Question: Briefly state, in one sentence, what is plotted here.
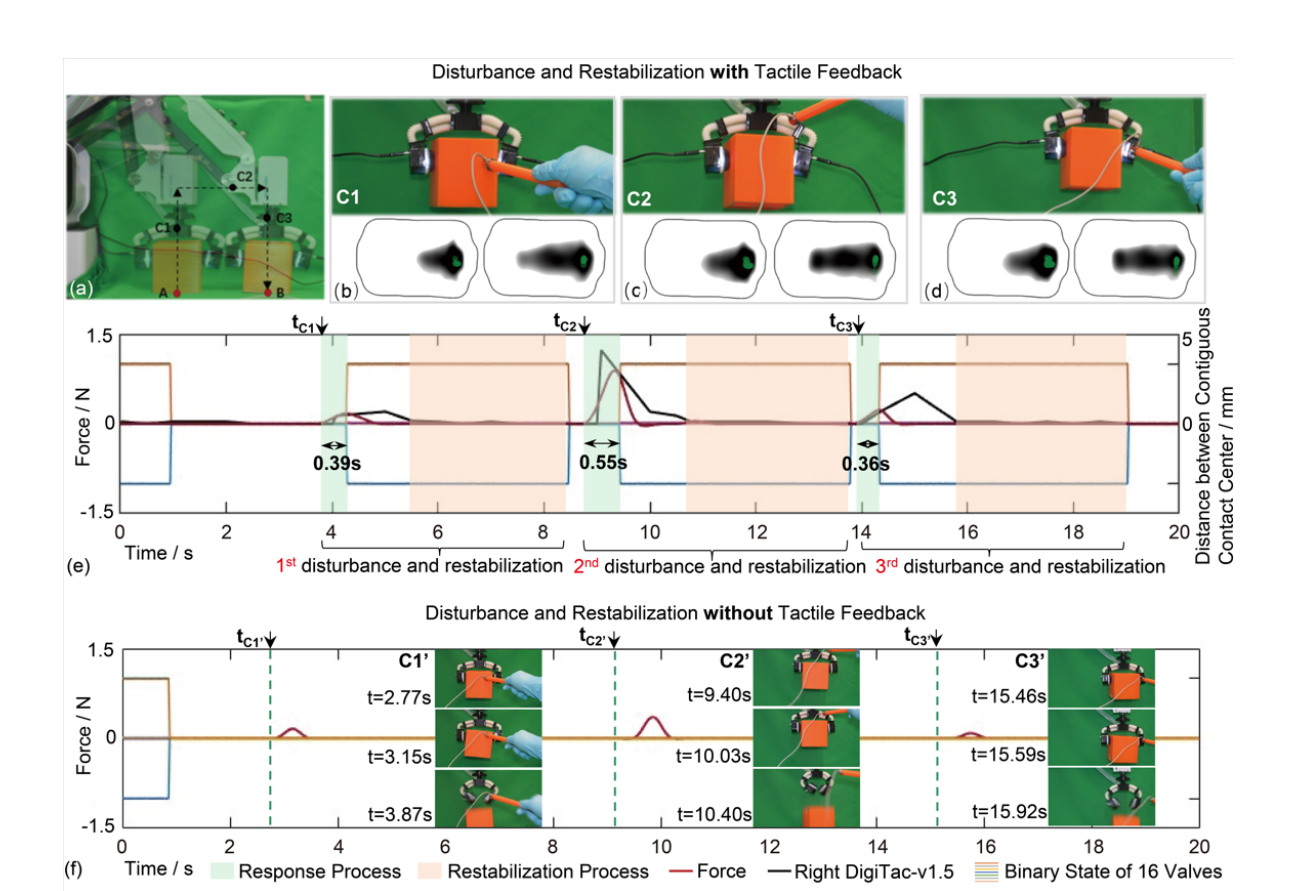
Answer: Disturbance and restabilization experiment with and without tactile feedback. (a) Experiment setup. (b) Initial disturbance when poking the object. (c) Second disturbance when poking the soft actuators. (d) Third disturbance when poking the rigid back of the fingertip. Tactile image kernel densities are shown at the moments of disturbance. (e) Plots showing the disturbing force from the probe (red curve), the motion of the centres of contact (black curves) and actuators/valves response. (f) Corresponding disturbance test without tactile feedback, showing a failure to maintain grip.